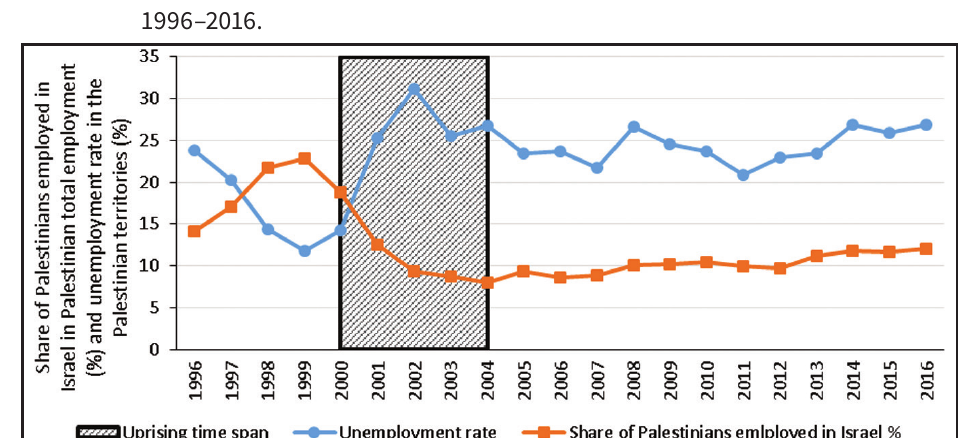
Figure 2 Evolution of the share of Palestinians employed in Israel in Palestinian total employment and the unemployment rate in the Palestinian territories,